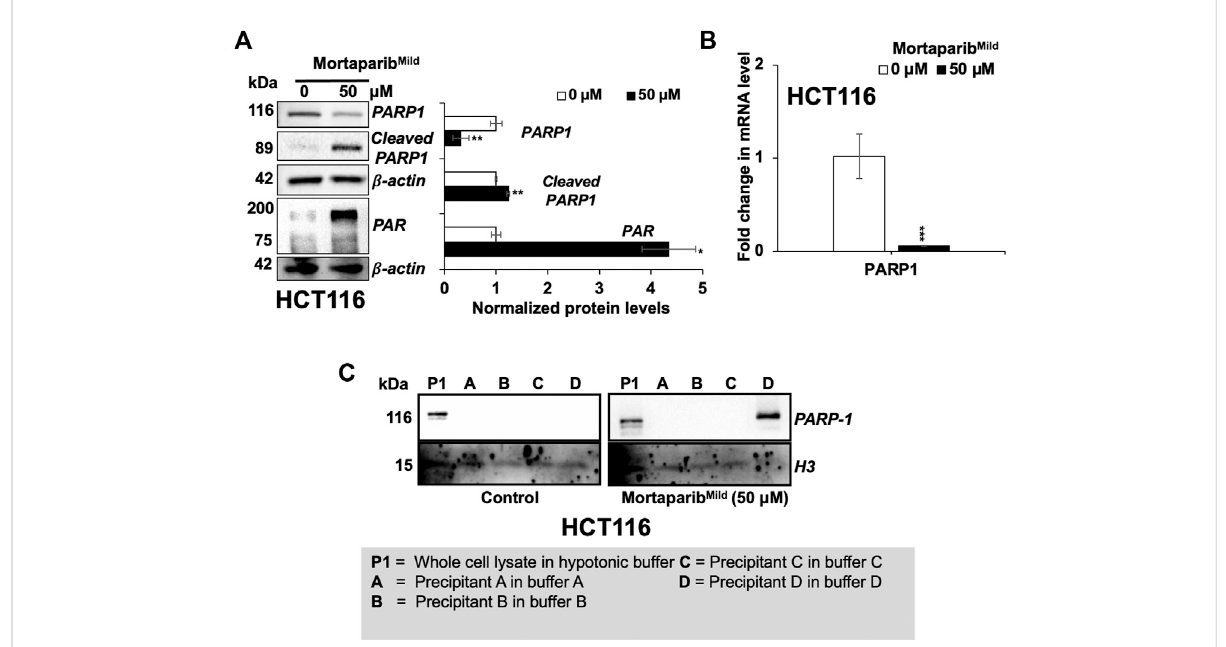
FIGURE 4 Mortaparib Mild caused downregulation of PARP1 expressionin HCT116 cells. (A) Westernblot probed with anti-PARP1, anti-Cleaved-PARP1and anti-PAR antibodies is shown. β -actin was used as an internal loading control. (B) mRNA expression of PARP1 as determined by RT-qPCR. (C) DNA trapping assay showing trapping of PARP1 in DNA in treated cells. Histone H3 was used as a loading control. Data were normalized against control and plotted as fold difference. Each data set represented the mean ± SD of at least three independent experiments. Statistical signi fi cance was de fi ned as values of p > 0.05 (ns), p ≤ 0.05 (*), p ≤ 0.01 (**), p ≤ 0.001 (***), and p ≤ 0.0001 (****), which represent non-signi fi cant, signi fi cant, very signi fi cant, highly signi fi cant, and extremely signi fi cant,